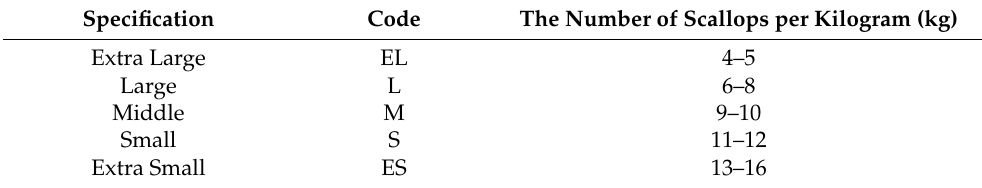
Table 1. Specification description in farm-gate price.